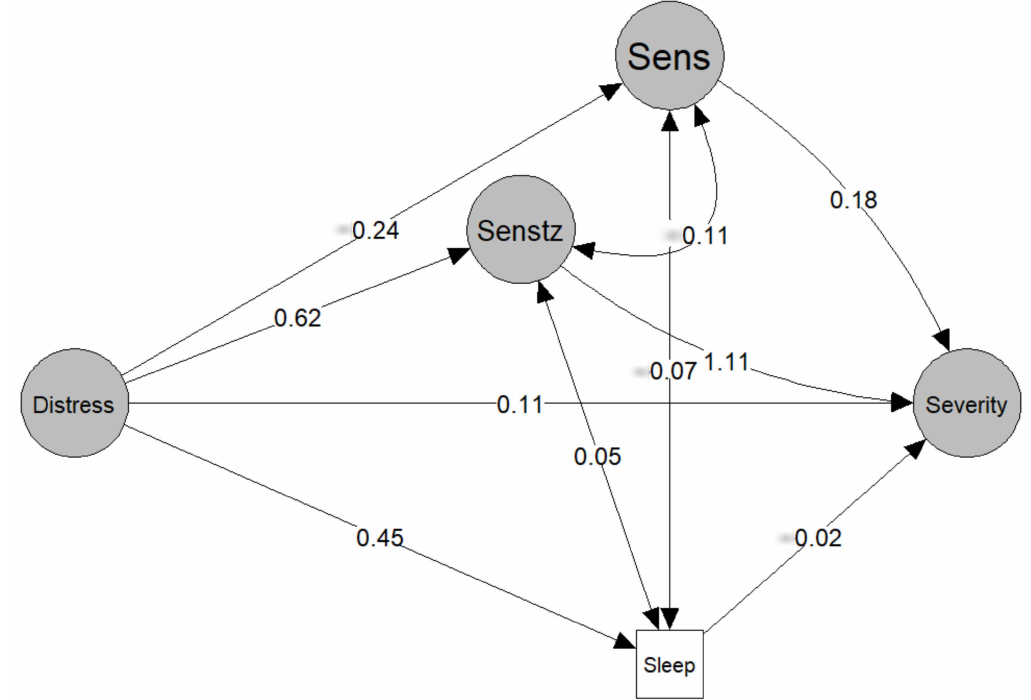
Figure 2. Structural equation model linking psychological distress to symptom severity in fibromyal- gia. Values represent the standardized β coefficient linking the effect of the independent variable (tail of the arrow) to the dependent variable (head of the arrow). Senstz: sensitization; Sens: sensitivity. Observed variables are not plotted to reduce visual